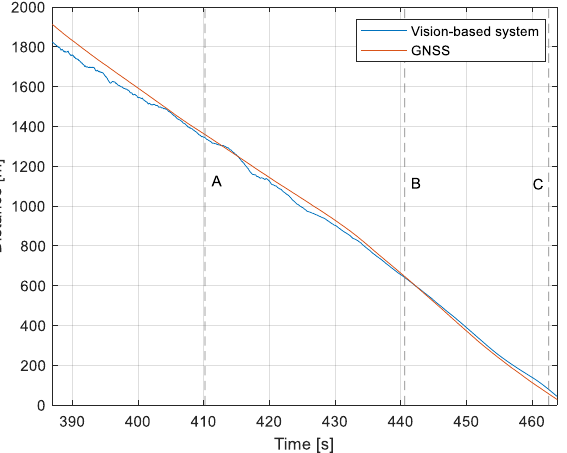
Figure 16. Distance from the runway: Flight no. 2 (markers A – C correspond to the moment of recording the images in Figure 11.